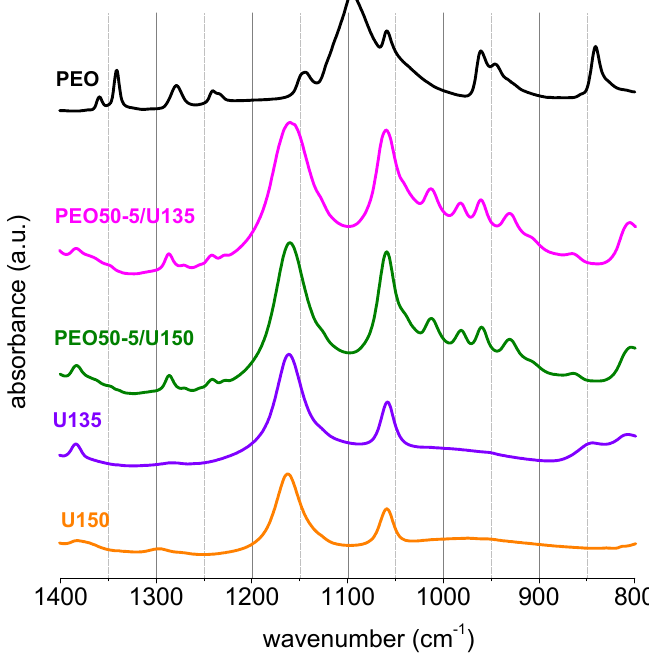
Figure 3. FT-IR of PEO50-5/U135, PEO50-5/U150, solid PEO and uralumina (150 and 135).